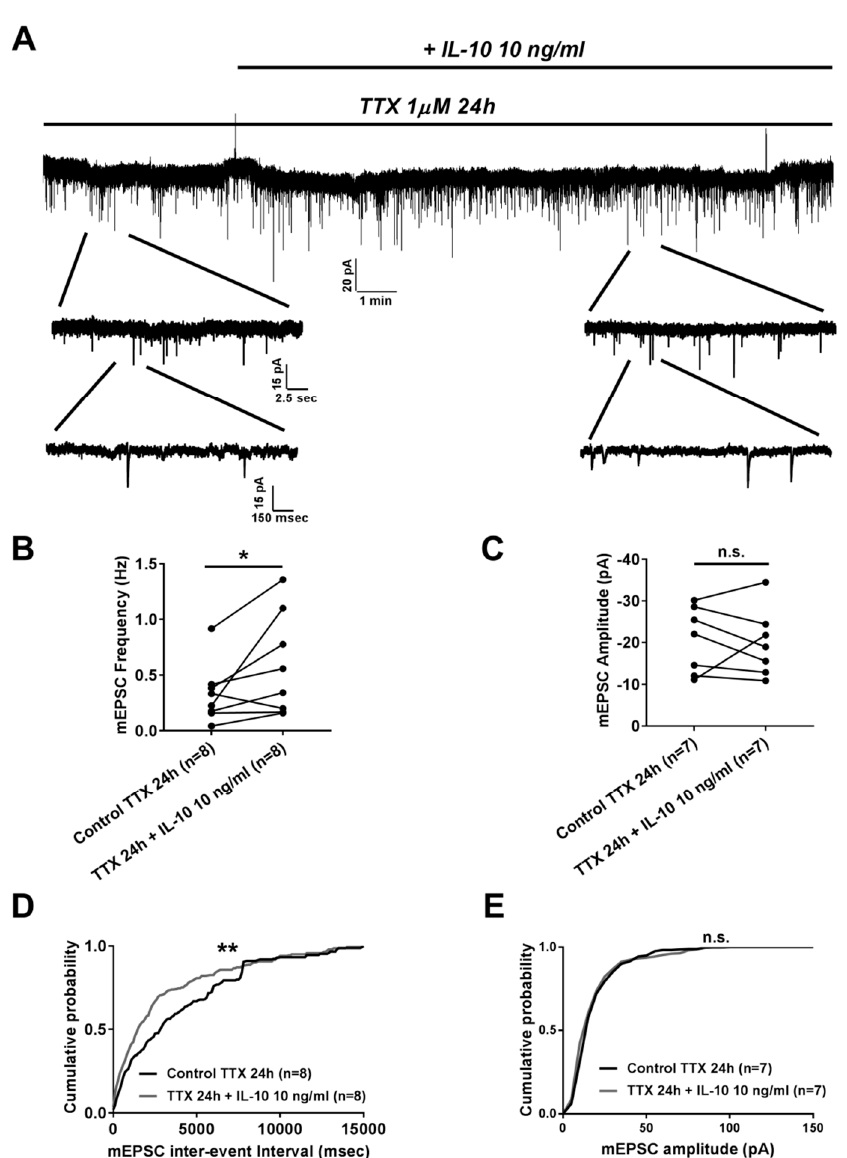
Figure 2. Application of IL-10 exerts presynaptic e ff ect on homeostatic synaptic plasticity modeled with 1 µ M TTX treatment for 24 h. ( A) Representative traces of mEPSC presented at di ff erent time scales. Exposure to IL-10 is indicated by the solid line. ( B ) Graphical plot representing mEPSC frequency before and 15 min after Il-10 application. ( C ) Graphical plot representing mEPSC amplitude before and 15 min after IL-10 application. ( D ) and ( E ) Cumulative probability distribution plots representing mEPSC inter-event interval (D) and amplitude (E) distribution before and 15 min after IL-10 application. * p < 0.05 with paired t -test; ** p < 0.01 with Kolmogorov–Smirnov